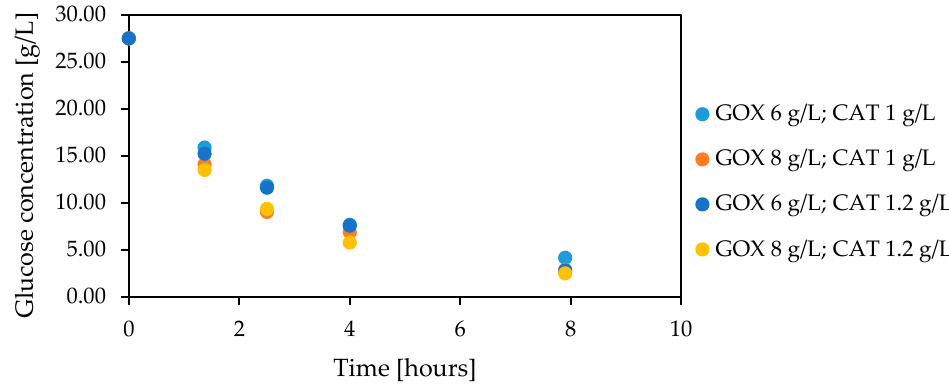
Figure 2. Selection of the proportion of native glucose oxidase and catalase during glucose decomposition (glucose 27.5 g/L, 0.1 M HEPES pH 6.6, 12 °C, CaCO 3 4 g/L, without aeration).